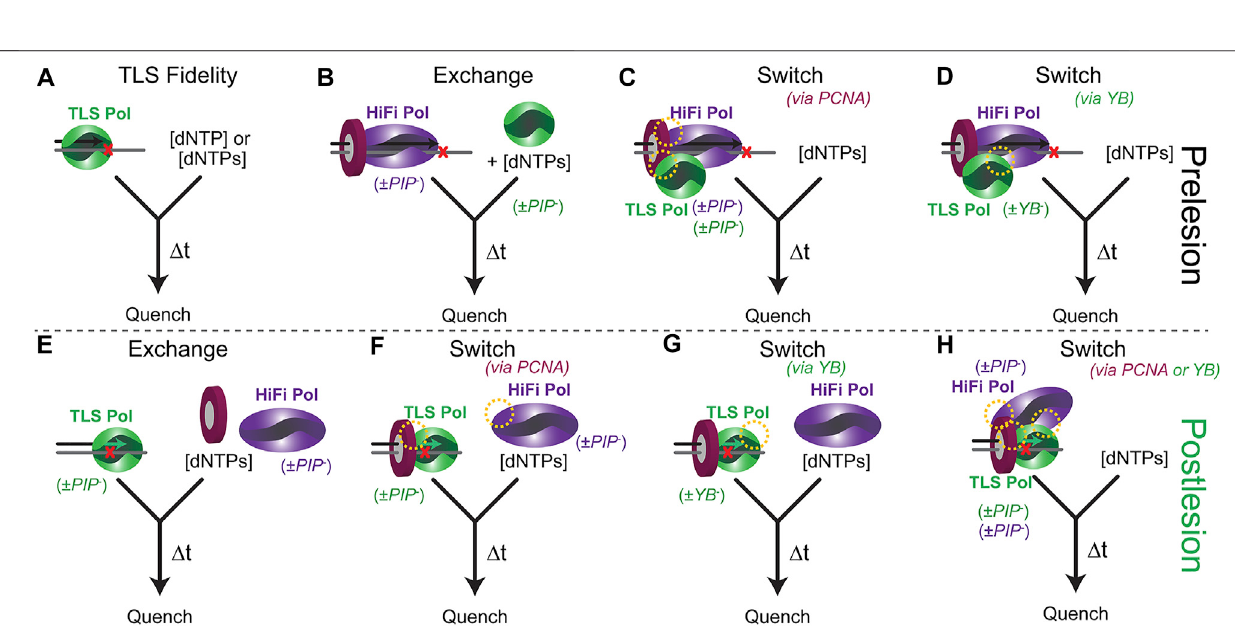
Frontiers in Molecular Biosciences |